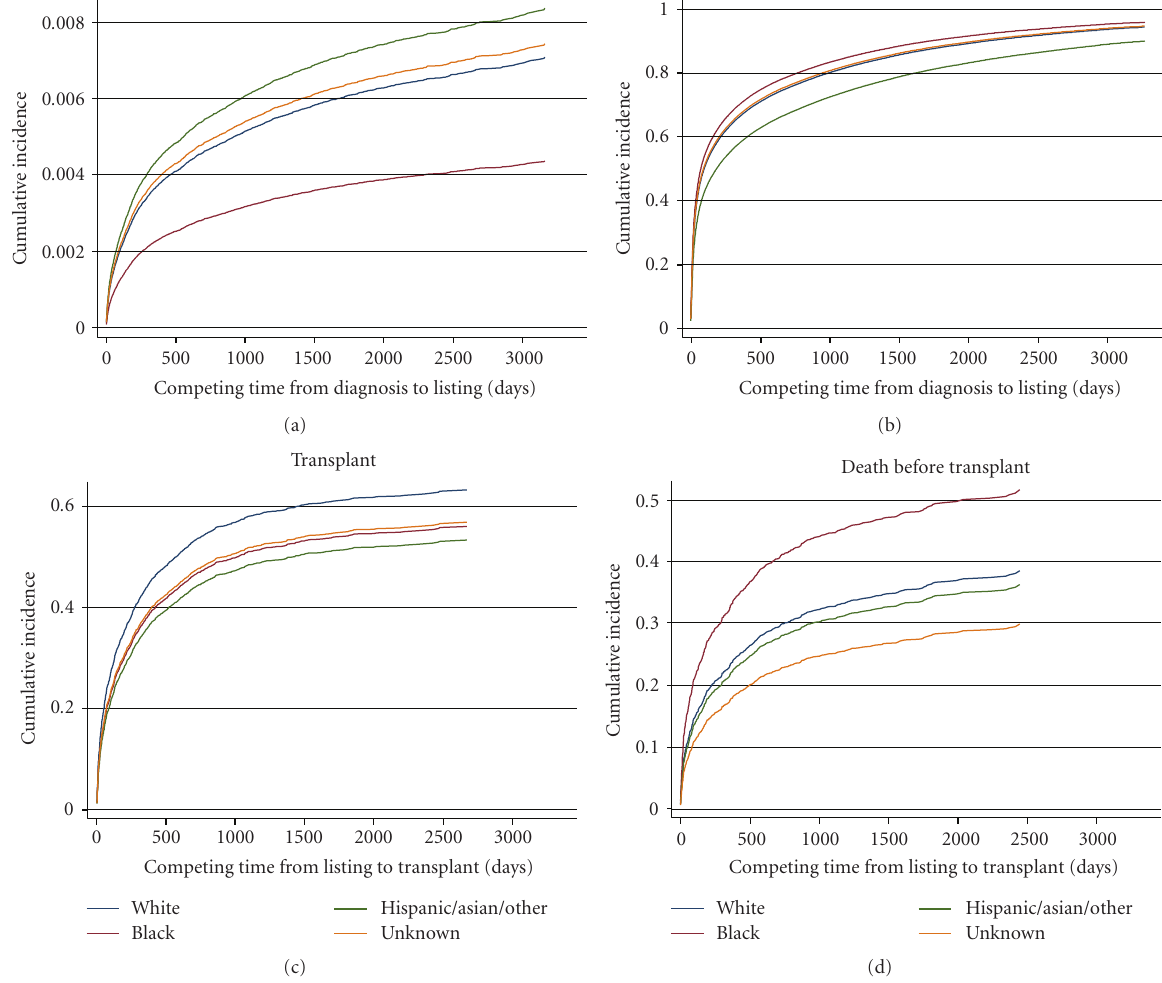
Figure 2: Race/ethnicity-based results in the adjusted competing risks